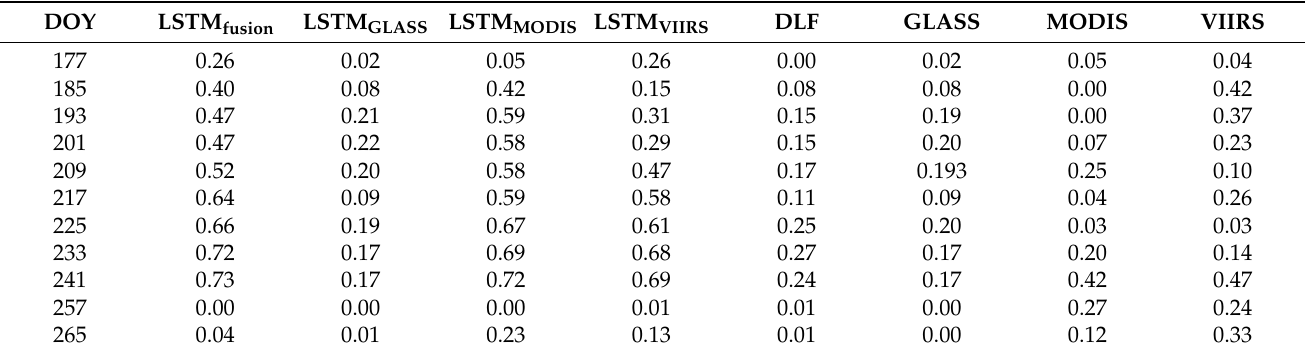
Table 4. R 2 between the retrieved and aggregated reference LAI on multiple ground-measured dates in